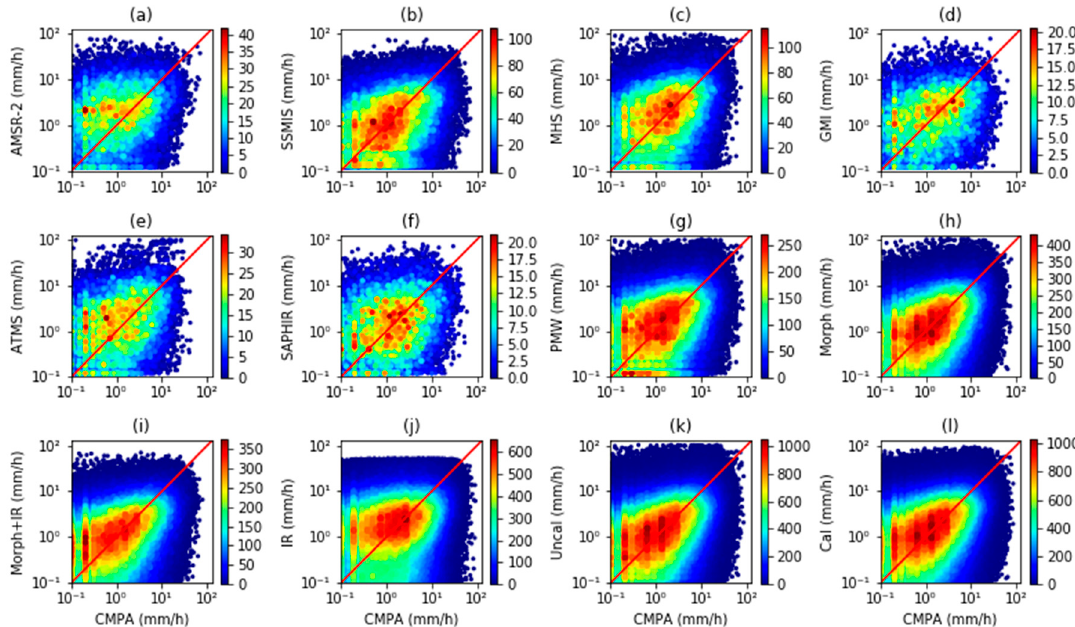
Figure 5. Distribution density of hit pairs of data for 12 IMERG estimates, including ( a – f ) six individual PMW, ( g ) merged PMW, ( h ) morphed PMW, ( i ) the mixture of morphed PMW and IR, ( j ) IR-only, ( k ) without and ( l ) with gauge adjustment estimates, and corresponding CMPA data in logarithmic scale. The statistics of them are indicated in Table 4.